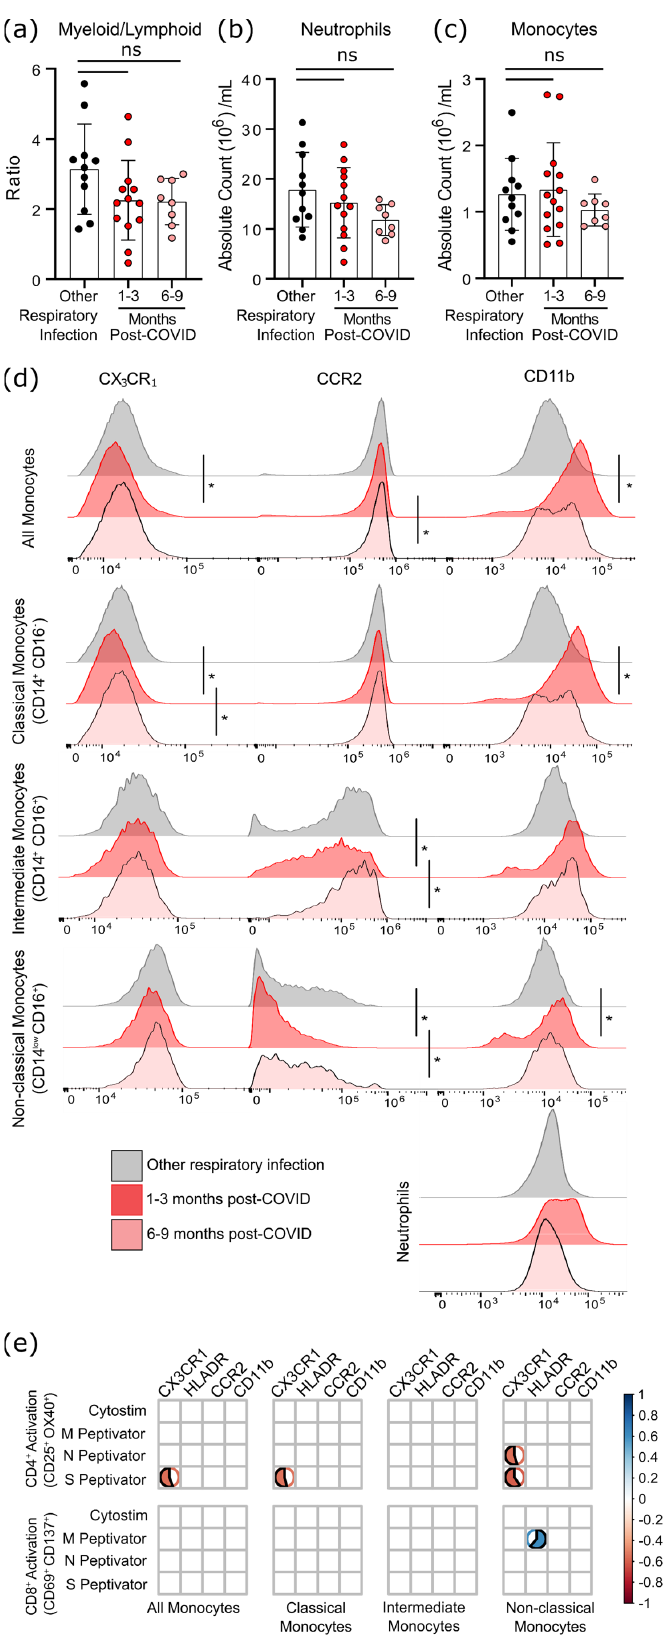
Figure 5. Evidence of sustained cellular inflammation after mild SARS-CoV-2 infection. ( a ) There was a trend towards a decreasing ratio of myeloid to lymphoid cells after SARS-CoV-2